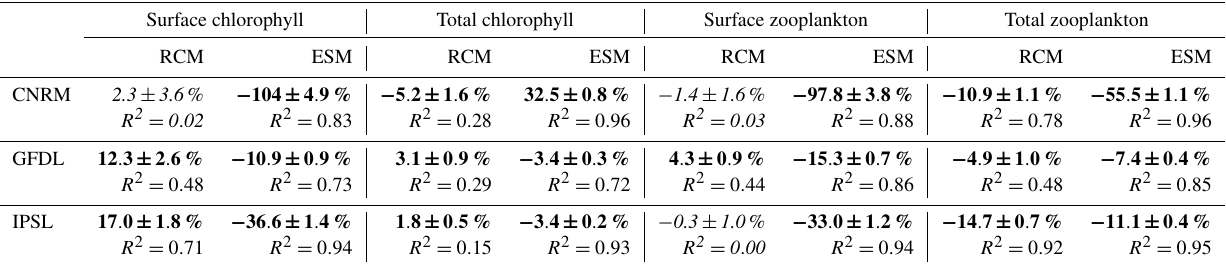
Table 5. Differences (in percent) between 2100 and 2006 (with respect to value in 2006) computed from RCM and ESM linear trends and R 2 for chlorophyll and zooplankton. Total chlorophyll and total zooplankton indicate depth-integrated values over 0–500m. Bold font indicates significant values with a 90% level of confidence. Italic font indicates values below the 90% level of